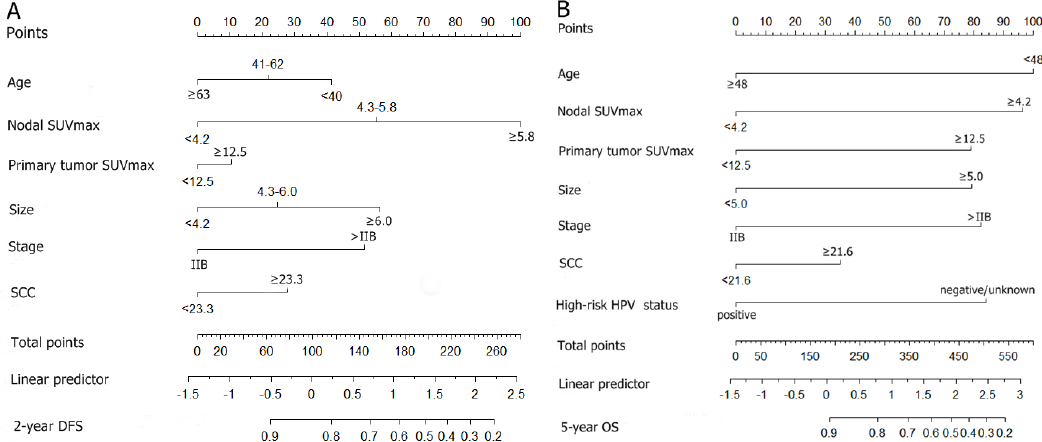
Figure 1. Nomogram for predicting the 2-year disease-free survival ( A ) and 5-year overall survival ( B ). Instructions for use of the nomogram. Draw a vertical line on the corresponding axis of each variable to the top line labeled “Points” to calculate the score for each variable. Add the number of points for all variables then draw a vertical line from the axis labeled “Total points” until it intercepts each of the survival axes to determine the 2-year disease-free survival and 5-year overall survival probability.